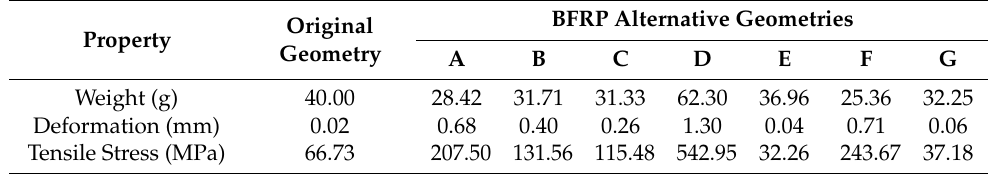
Figure 9. Different iterations designed for the BFRP component. Table 5. Properties comparison between the Original and BFRP alternative geometries.